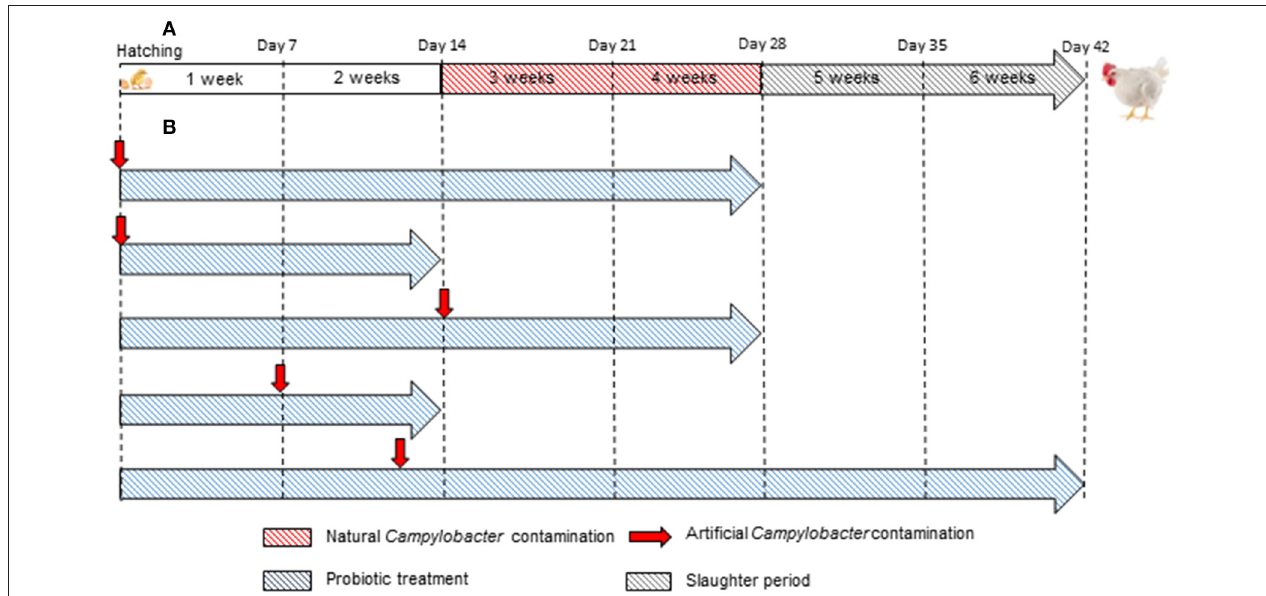
FIGURE 5 | Comparison between (A) commercial broiler chicken production and (B) in vivo studies designed to evaluate the efficacy of probiotics to reduce the colonization of C. jejuni . In almost all in vivo studies, the duration and/or artificial Campylobacter contamination are not in accordance with the duration and natural Campylobacter contamination in commercial broiler chicken